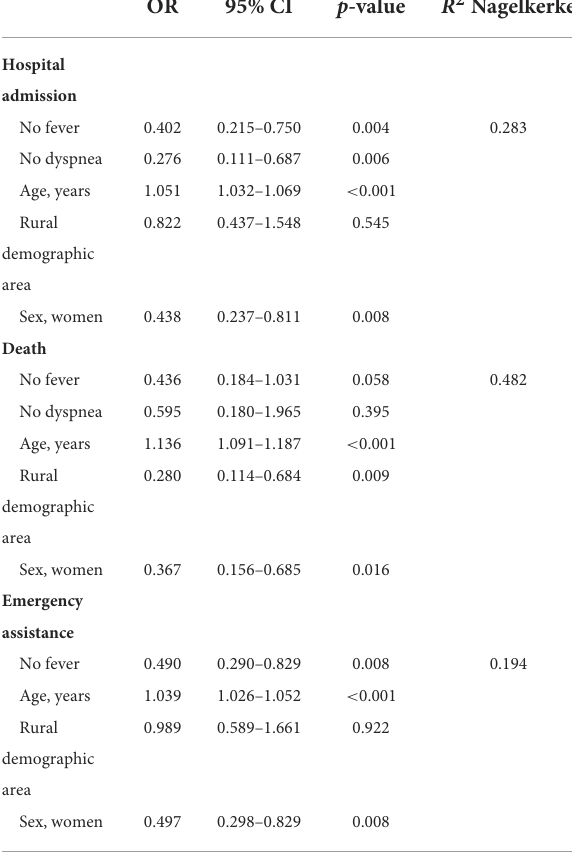
TABLE 3 Multivariate regression based on hospitalization, deaths, or emergency assistance as a function of baseline symptomatology. OR 95% CI p -value